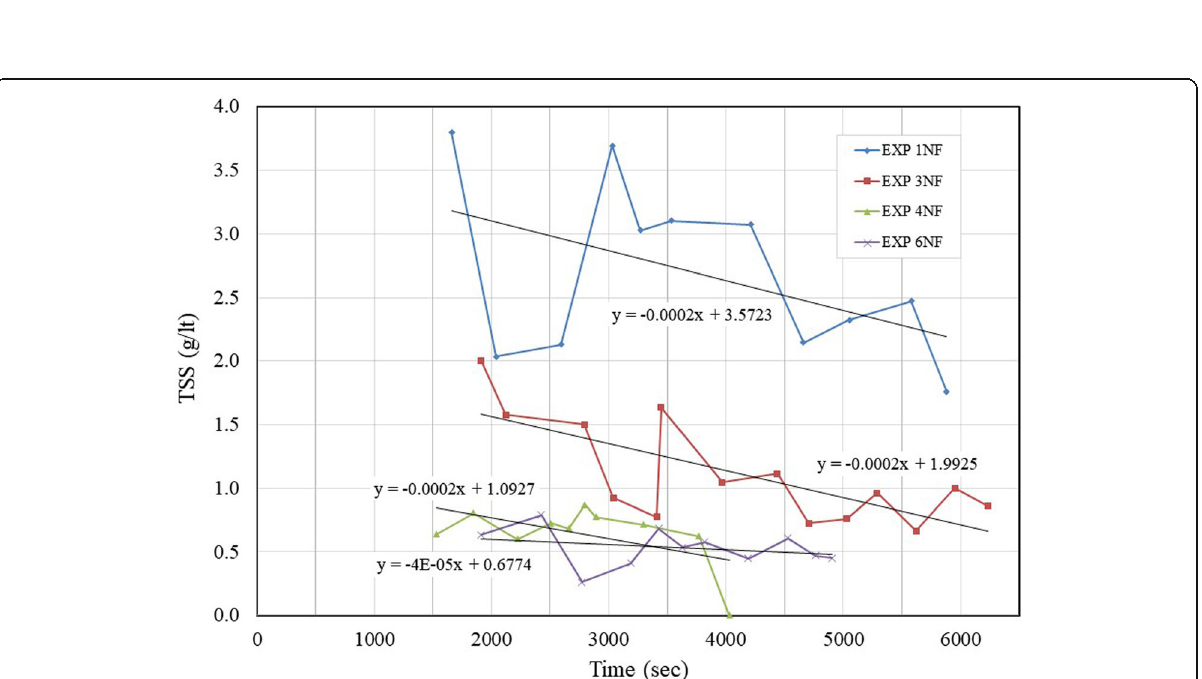
Fig. 11 Trend of TSS for different samples (not failure condition)